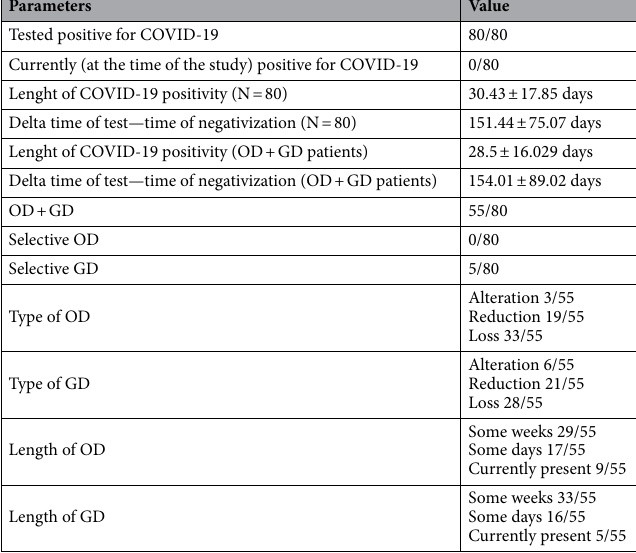
Table 1. Covid-19 symptom details in relation to OD + GD (olfactory and gustatory dysfunction).